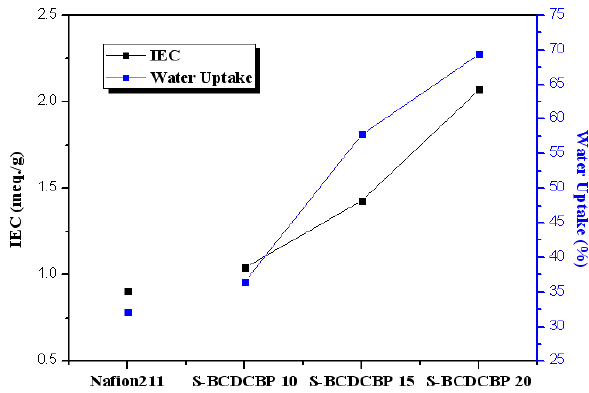
Figure 3. Ion exchange capacities (IECs) and water uptakes of sulfonated polymers. Table 1. Properties of polyphenylene membranes.